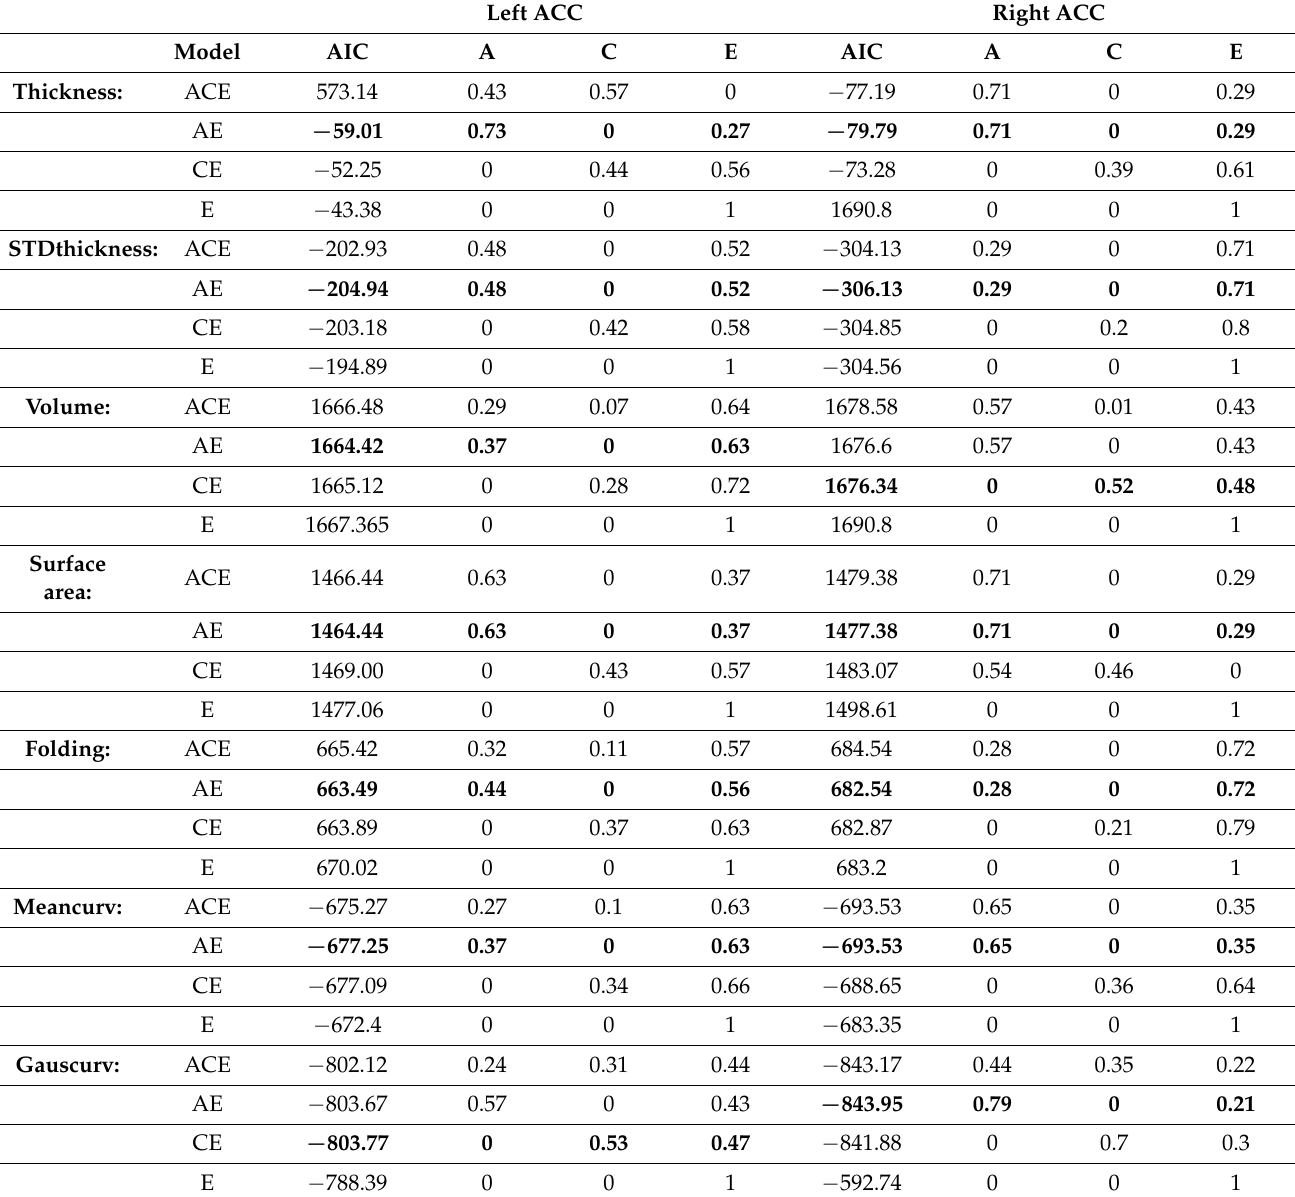
Table 6. Structural equation modelling results of surface morphological